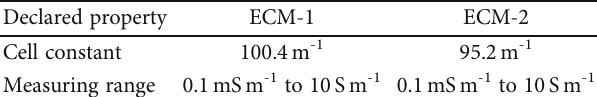
Table 1: The declared cell constant and measuring range of two electrolytic conductivity meters commercially available. Declared property